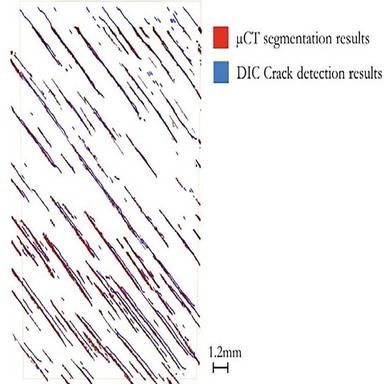
Superposition of the crack detection result carried out using µCT scan segmentation and DIC crack detection procedure for the first ply of the specimen tested in air after 770 k cycles. Small differences on top and bottom of the figure are due to a slight misalignment in the 3D and 2D selections made.